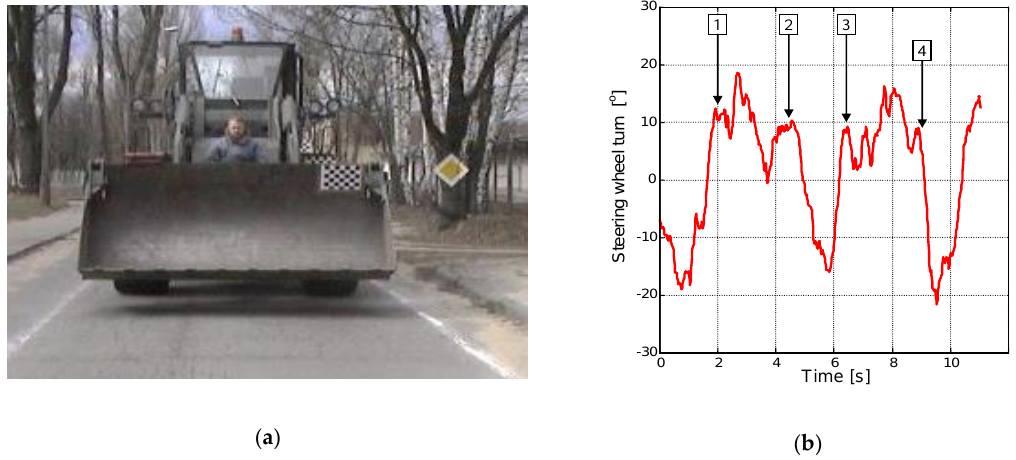
Figure 5. View of the modified loader with driver before front axle and direct hydraulic steering system during straight-line test ( a ), and driver reactions during modified loader straight-line test at a speed 28 km/h ( b ).